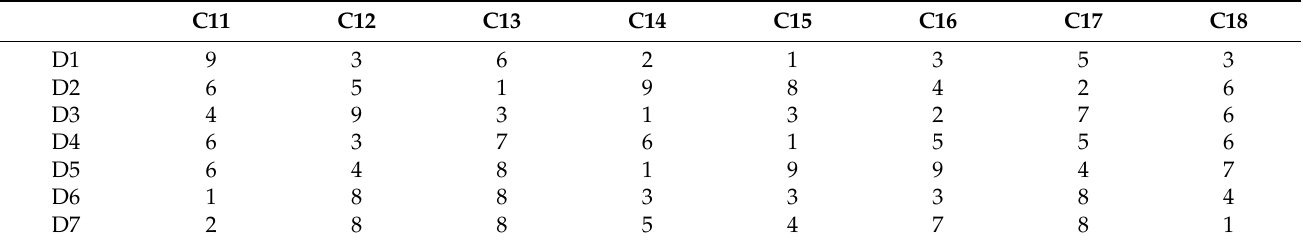
Table 2. Others-to-worst comparison between eight criteria in the carrier selection problem.